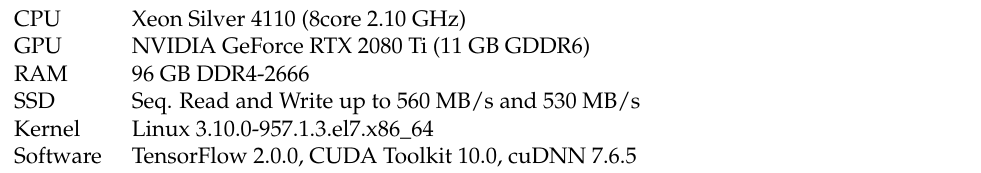
Table 3. Specifications of the computer used for implementation and calculation. CPU